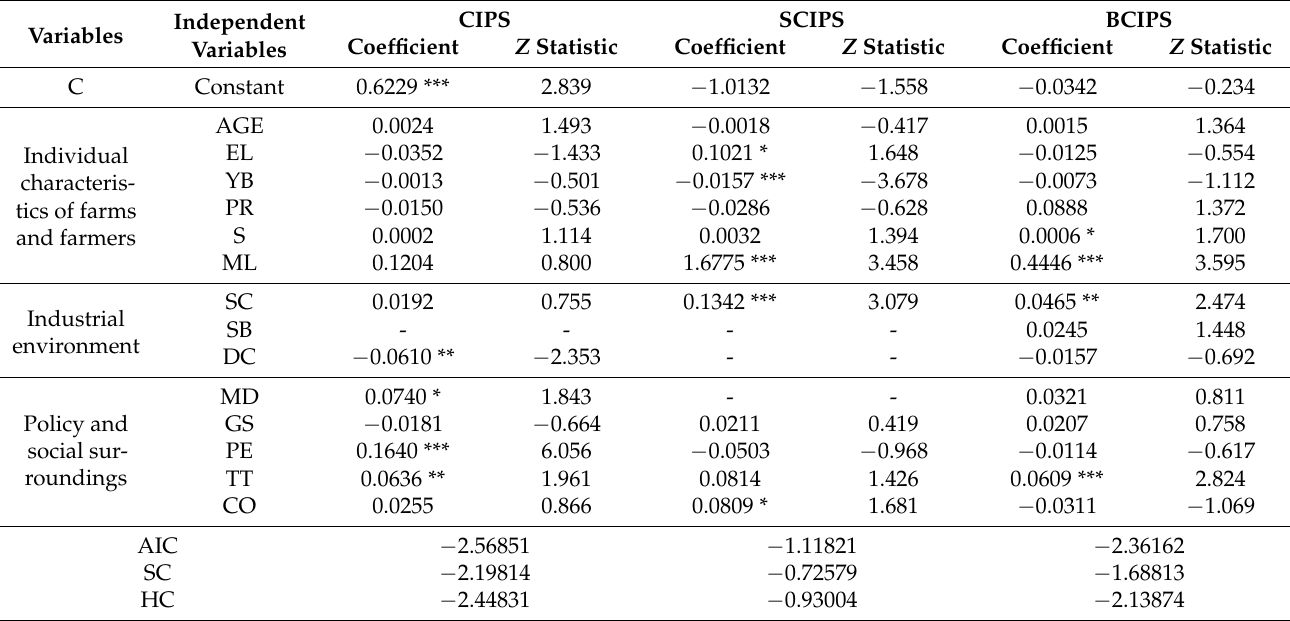
Table A2. Results of the Data Fit Analysis of the Tobit Models.